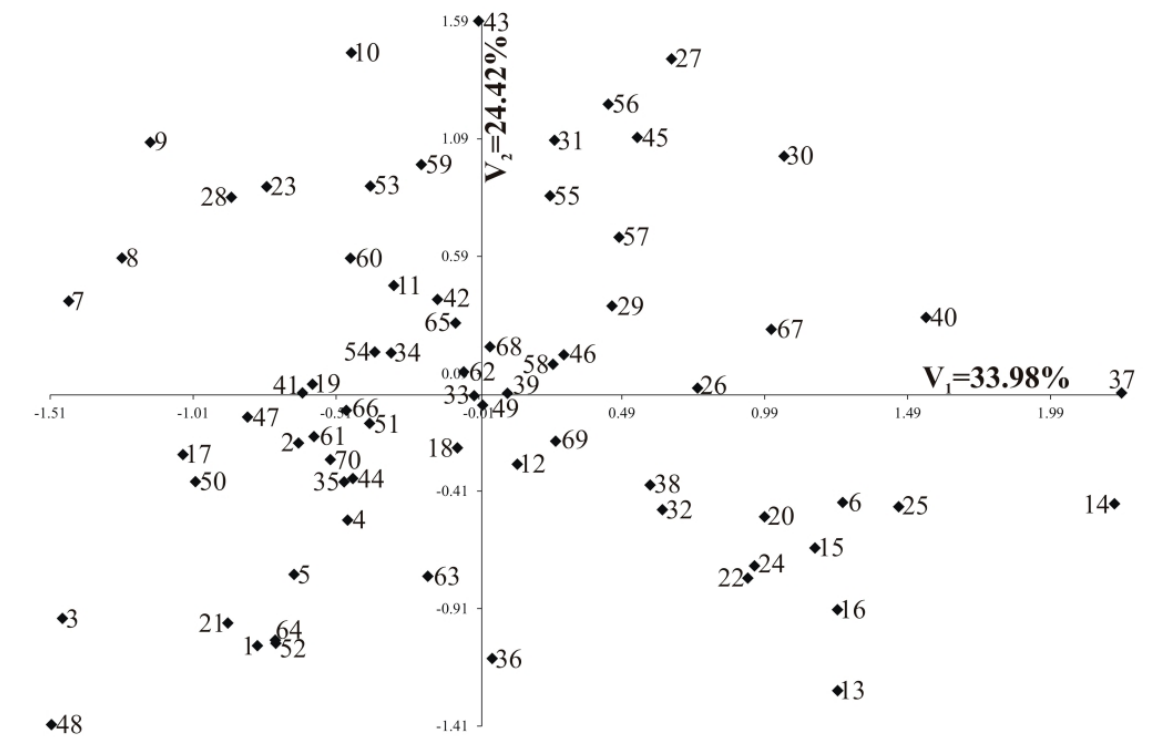
Figure 8. Distribution of 70 Rubus samples in the space of the first two canonical variables. Table 7. Correlation coefficients between the first two canonical variables and original traits.